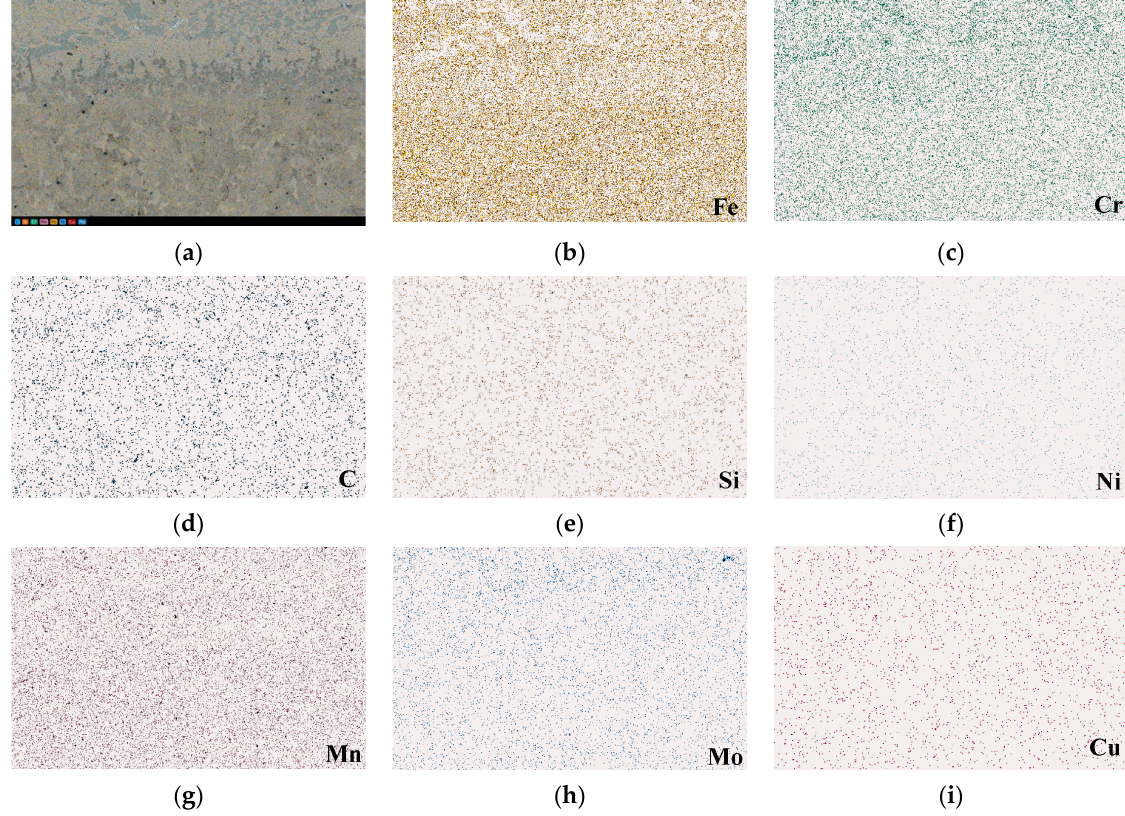
Figure 14. BSD image ( a ) and element distributions ( b – i ) in specimen S2. The hardness near the interface of specimen S2 was also tested. The hardness results and corresponding indentations are shown in Figure 15. The HCCI has a high